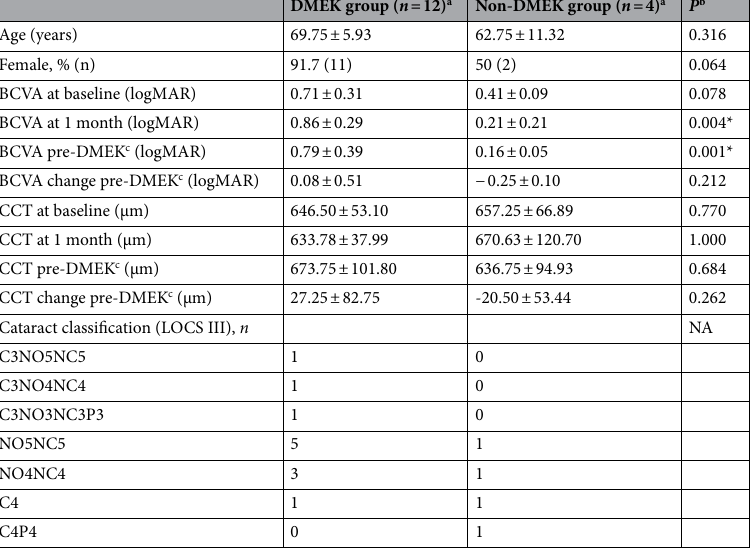
Table 3. Subgroup analysis: In the case group, those who proceeded to DMEK after cataract surgery and those who did not. a All values are presented as mean ± SD unless otherwise noted. b Mann-Whitney U test. c CCT and BCVA documented at 6 months if DMEK surgery was deferred. BCVA, best corrected visual acuity; CCT, central corneal thickness; DMEK, Descemet’s membrane endothelial keratoplasty.